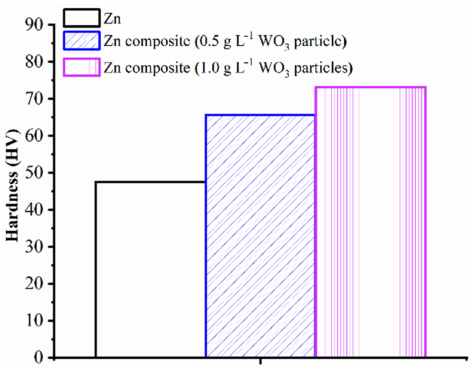
Figure 9. Microhardness measurements of Zn and Zn–WO 3 deposits.